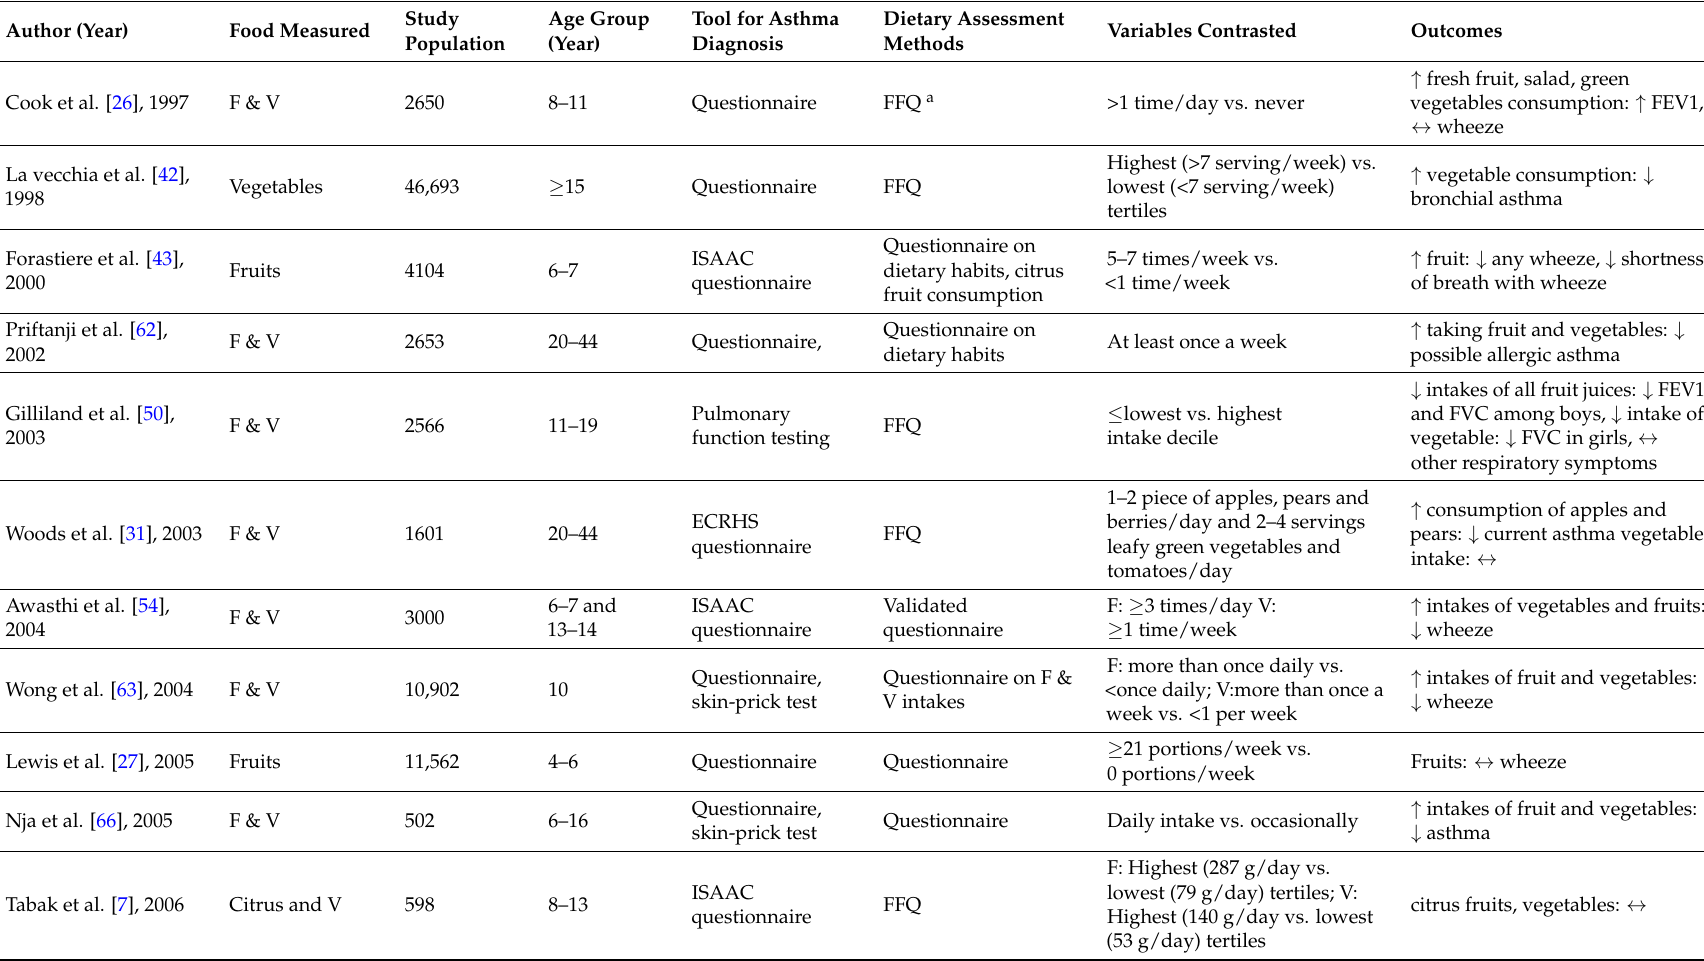
Table 1. Summary of cross-sectional studies on the association between fruit and vegetable intake and